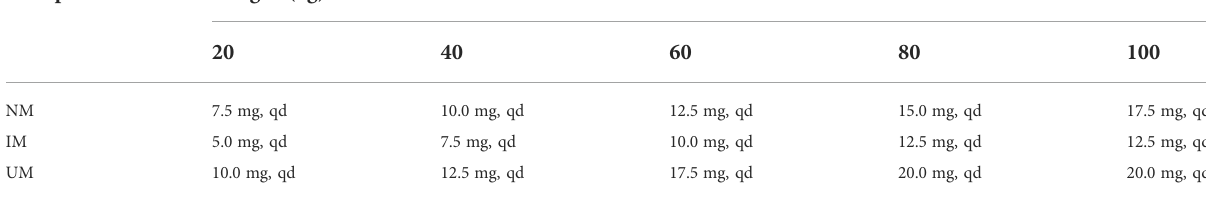
TABLE 5 Optimal dosage regimens for patients of different CYP2D6 genotypes.